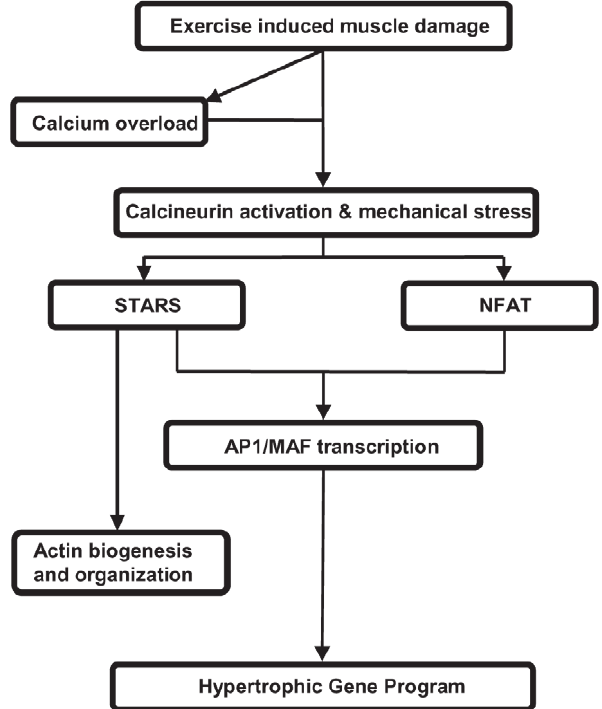
Figure 6. Regulatory and downstream targets of STARS transcriptionally active following a single bout of eccentric exercise. RCAN – regulator of calcineurin; HMOX1 – hemeoxygenase 1; ARHGEF7 and ARHGEF12 – Rho guanine nucleotide exchange factor 7 and 12; ARHGAP24 – Rho GTPase activating protein 24; RND3 – Rho family GTPase 3; DIAPH1 – diaphanous homologue 1; CORO1C – Coronin, actin binding protein 1; FLNB – Filamin B, beta; CAPZA1 – capping protein (actin filament) muscle Z-line alpha 1; ACTA2 –